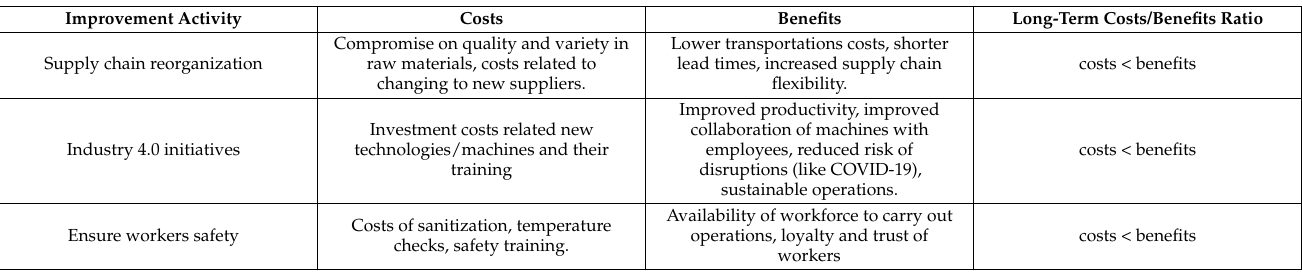
Table A8. Economic impacts of proposed